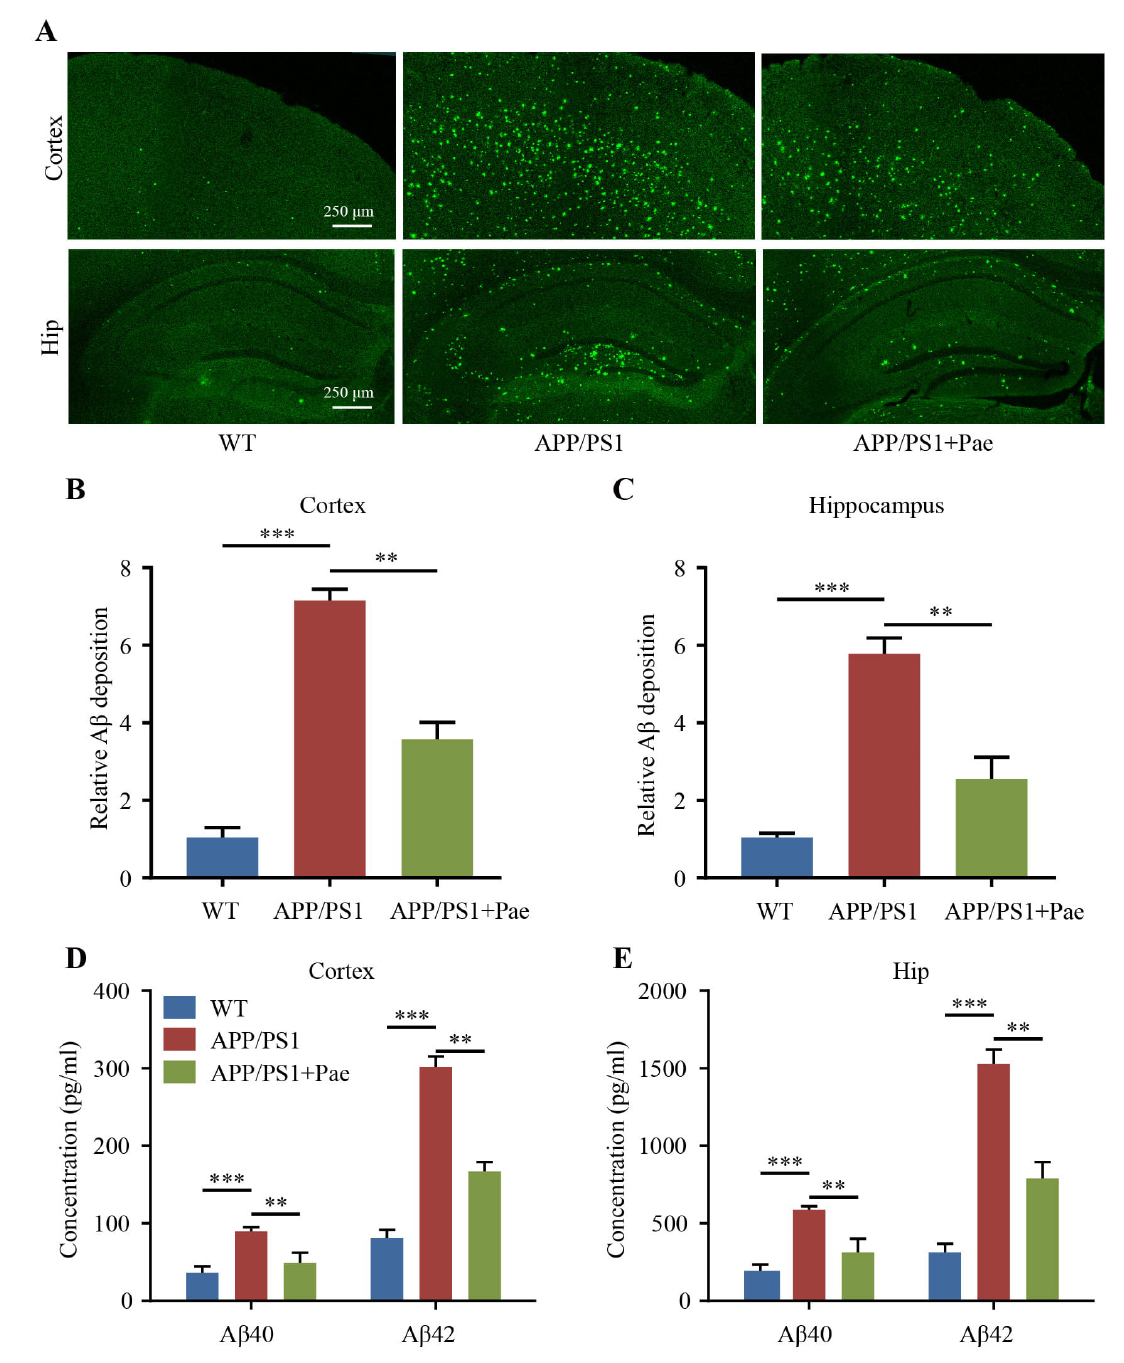
Fig. 2. Paeonol adminstration decreased A β plaques burden in APP/PS1 mice. (A–C) Immunofluorescent labelling and quantification results of A β plaque deposition in the cortex and hippocampus. Scale bar = 200 µ m. (D,E) ELISA results showed a significant reduction in soluble A β 40/42 in both the cortex and hippocampus. Mean ± SEM was shown (n = 7 mice). ** p < 0.01, *** p <